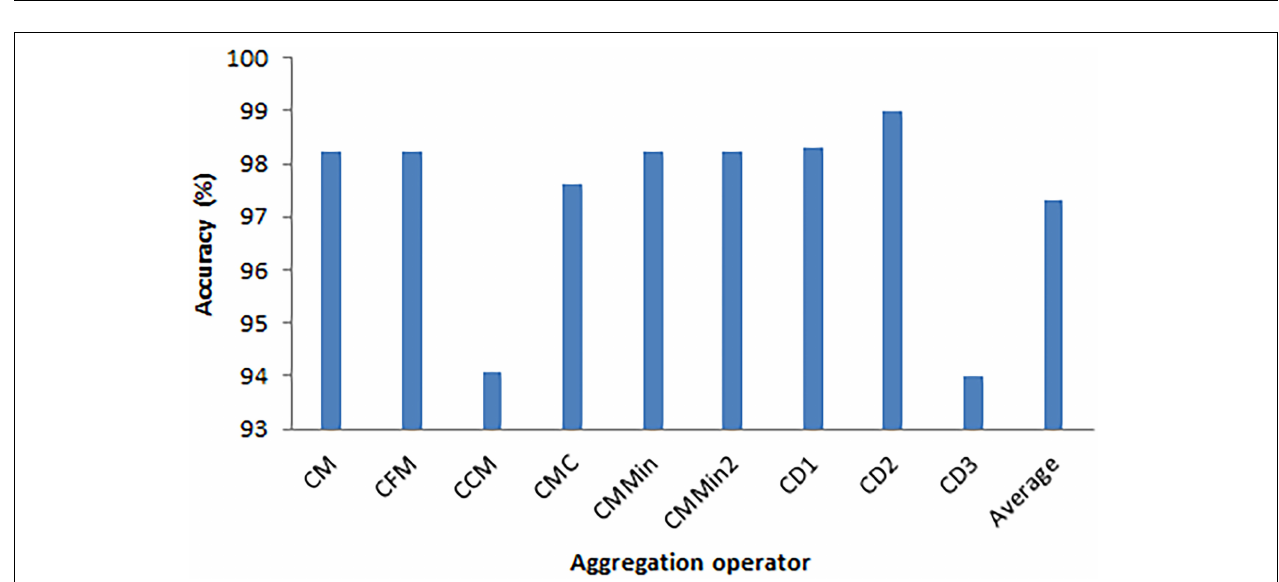
FIGURE 3 | The accuracies were obtained with the function (18) and aggregation operator C D 2